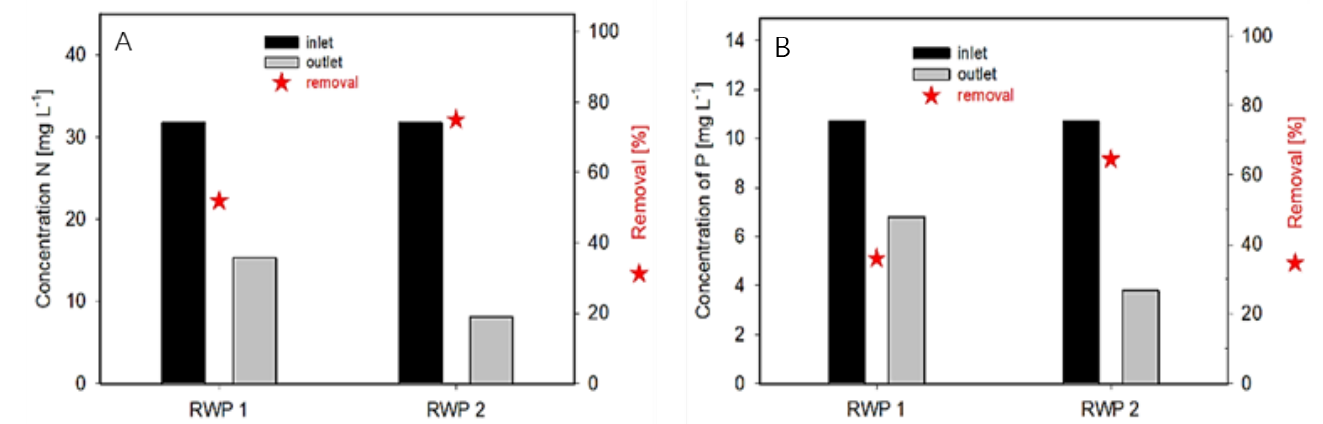
Figure 3. Nitrogen ( A ) and phosphorus ( B ) content in municipal WW and removal efficiency by microalgae cultures at the output in the bioreactors RWP1 and RWP2. The WW (inlet) and microalgae culture (outlet) were supplied/harvested continuously over the day and then averaged samples were analyzed for bioreactors RWP1 and RWP2.